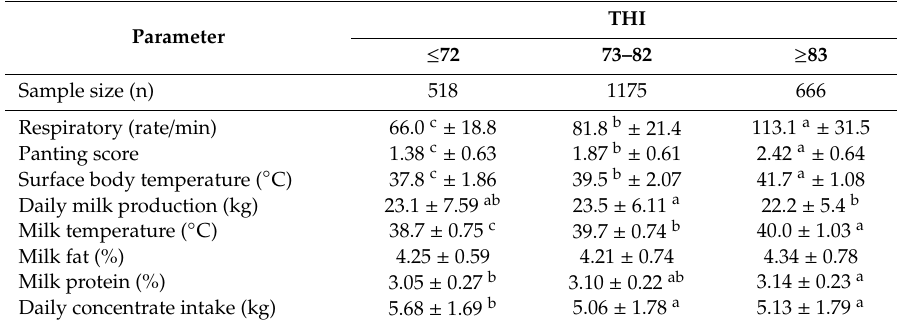
Table 2. E ff ect of THI (Temperature-Humidity Index) on physiological and milk parameters (Mean ± SD) of dairy